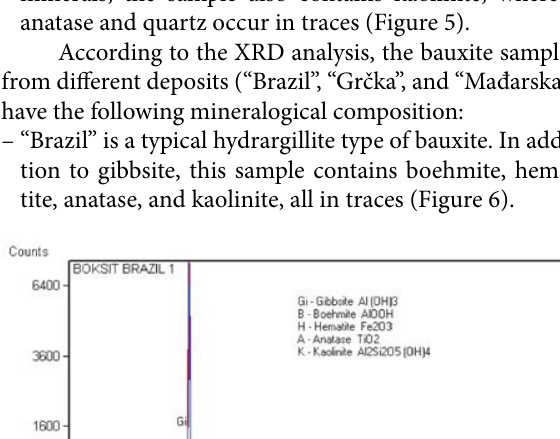
Figure 6. Diffractogram of the bauxite sample “Brazil” – “Grčka” bauxite is diaspore bauxite with a boehmite and hematite contents. In addition to those minerals, the sample also contains calcite and anatase, whereas quartz, kaolinite, gibbsite, goethite, and rutile are present in traces (Figure 7).